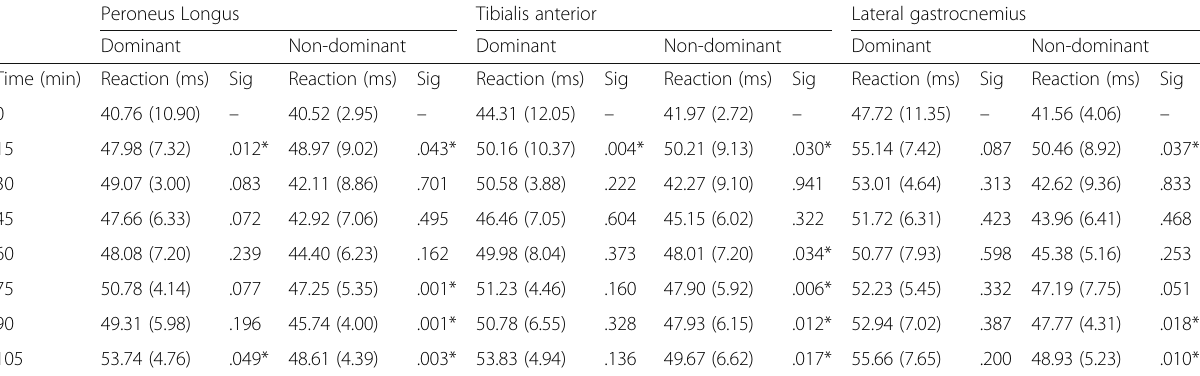
Table 2 Reaction times of each of the three muscles in the dominant and non-dominant limbs at different time points (standard deviation in bracket) Peroneus Longus